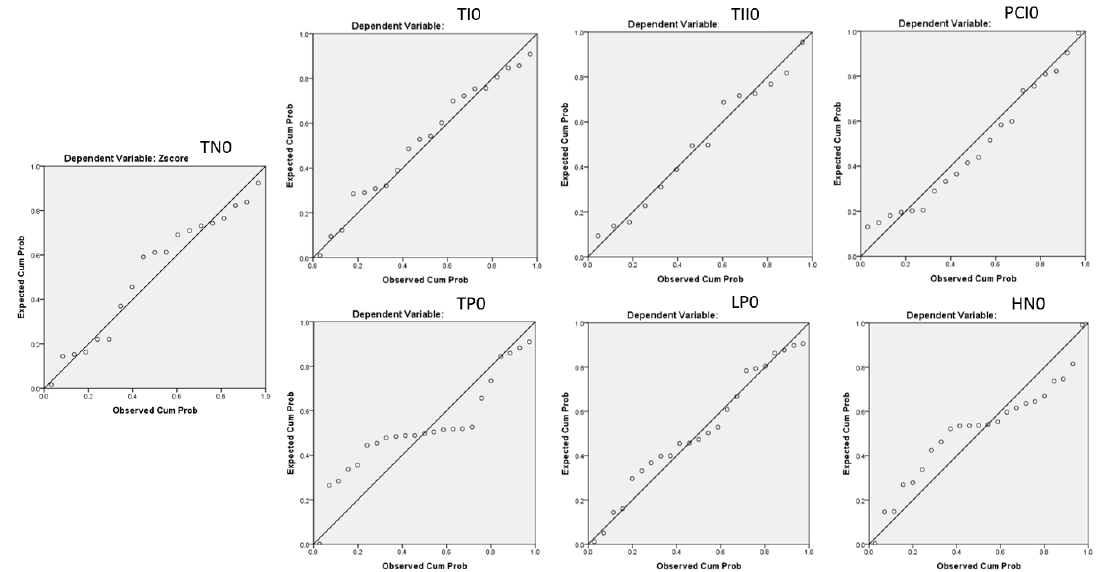
Figure 6. Normal P-P plot regression standardized residual. First, the adjusted R square of TN was 0.615 (>0.5). This shows that the hosting areas (TN21, TN5, and TN4) had a high positive impact on the Niigata area (TN0). Second, the adjusted R square of TI was 0275 (<0.3). This shows that the hosting areas (TI 21, TI 5, and TI 4) had an insignificant positive impact on the Niigata area (TI 0).